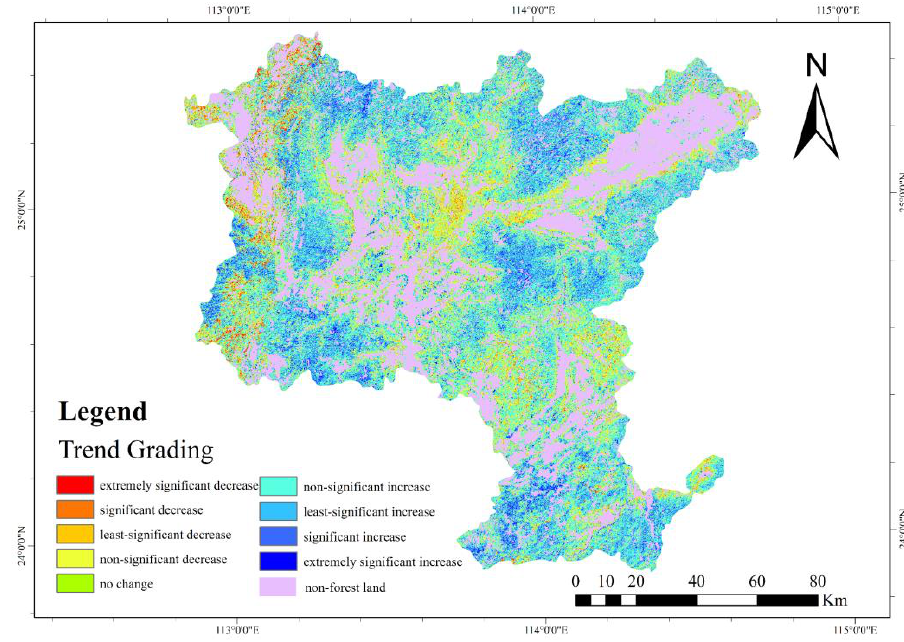
Figure 4. Temporal changes of NPP in Shaoguan from 1997 to 2017.